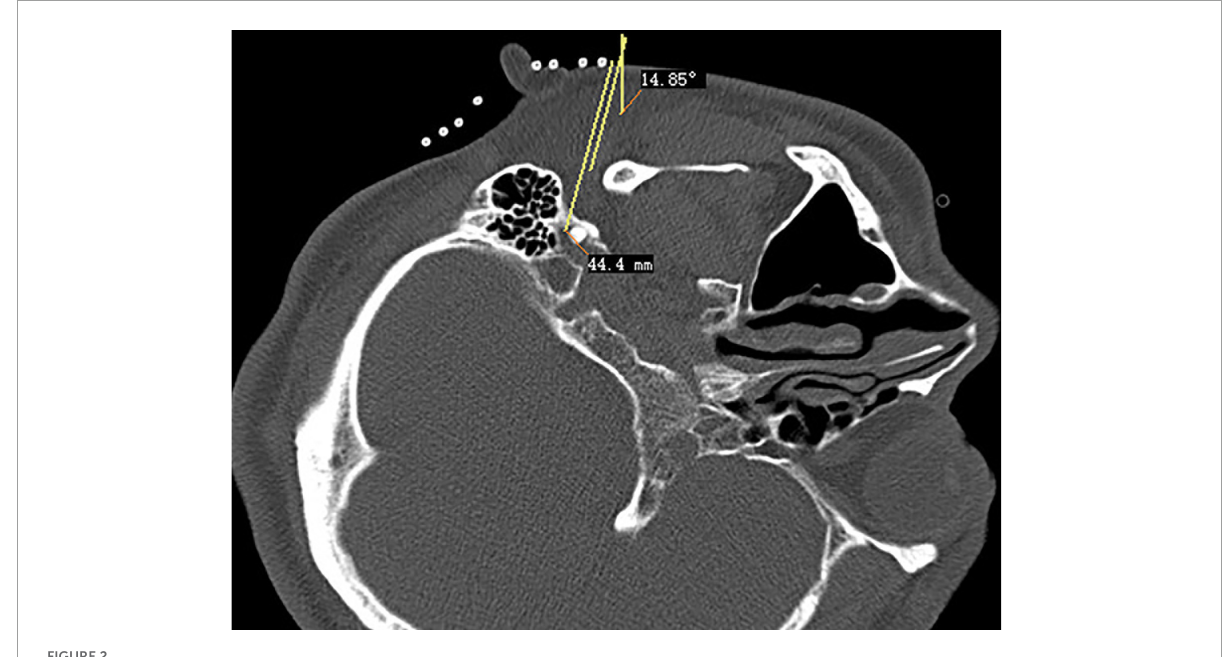
FIGURE2 Puncture path design of stylomastoid